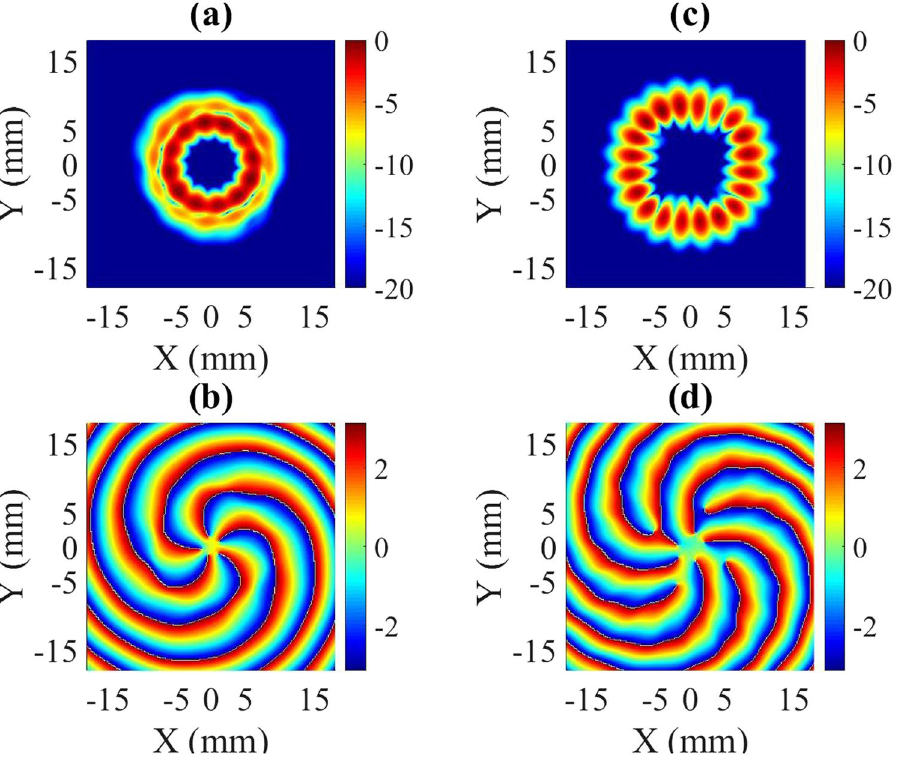
Figure 6. ( a ) Calculated amplitude and ( b ) phase of the time-averaged field of the TE 6,2 mode at 94.8 GHz. ( c ) Calculated amplitude and ( d ) phase of the time-averaged field of the TE 10,1 mode at 98.6 GHz.